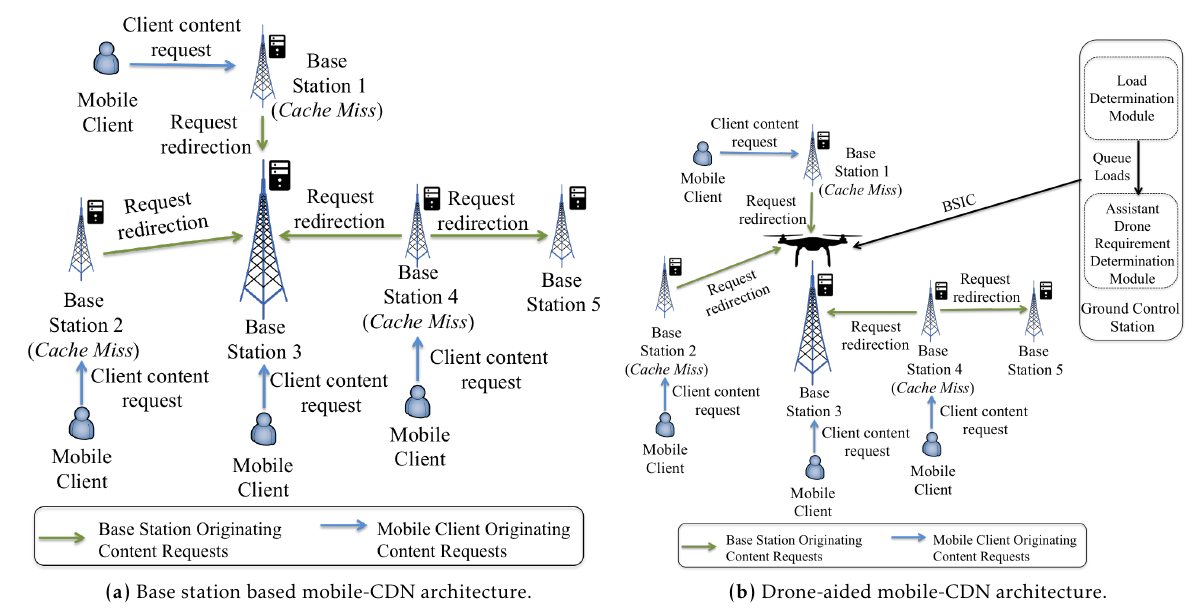
Figure 3. Mobile-CDN architectures for the base station based and proposed